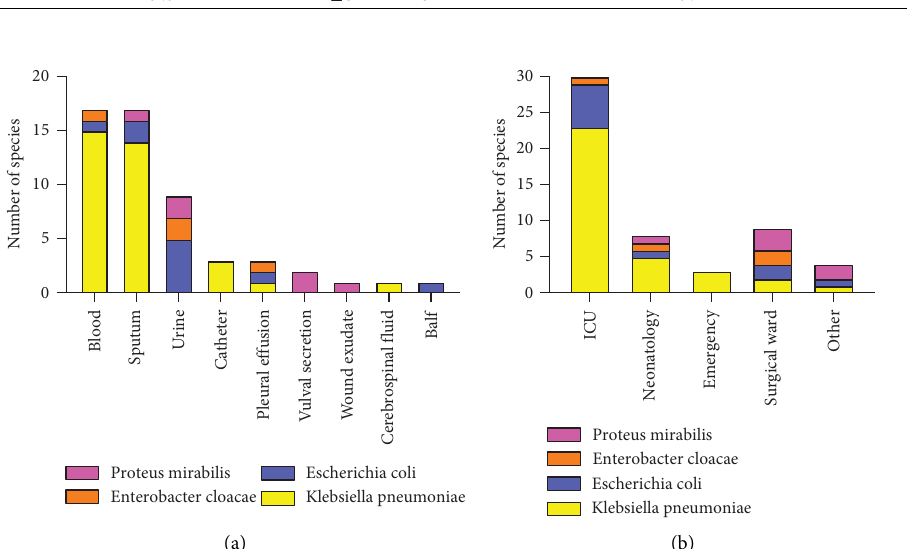
Figure 1: (a) Distribution of CRE strains isolated from diferent samples and (b) the distribution of CRE strains in diferent departments. ICU, intensive care